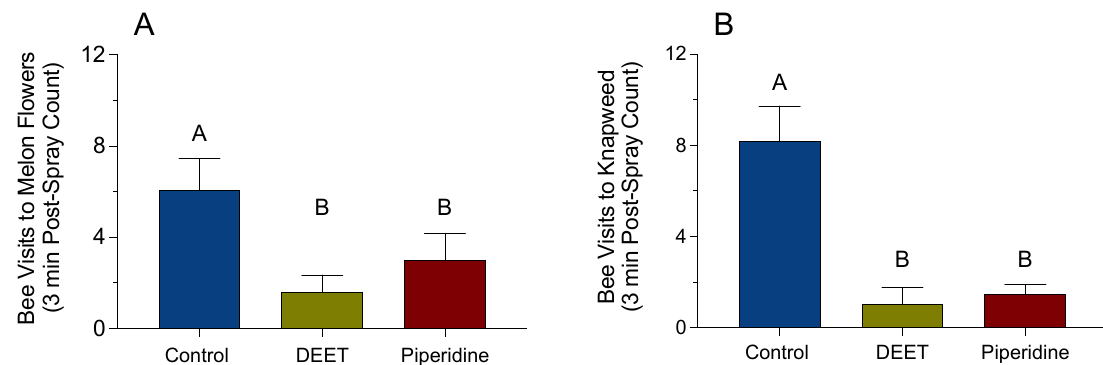
Figure 7. Effect of DEET and piperidine on the visitation of honey bees to melon flowers and knapweed bundles. Melon flowers ( N = 240) and knapweed bundles ( N = 51) were treated with deionized H 2 O (control), 10 µ L/mL DEET, or 10 µ L/mL piperidine. A 3 min post-spray count of visitation was performed and repeated 12 times in the melon plots and 17 times in the field of knapweed. ( A ) Mean number of honey bees and squash bees visiting the melon flowers post-spray (F (2, 33) = 4.13, P < 0.02). ( B ) Mean number of honey bees visiting knapweed bundles post-spray (F (2, 48) = 15.67, P < 0.0001). Vertical bars represent the mean ± standard error. Different letters above the bars indicate a significant difference using an ANCOVA with Student’s multiple comparison t -test.